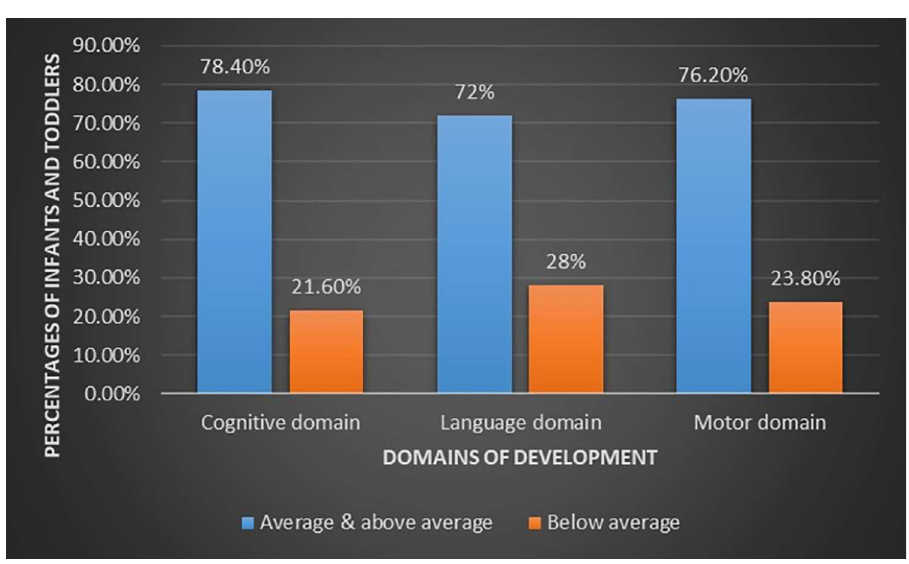
Fig 4. Classification of participants into two groups (Average & above average group and below average group) according to the cutoff point of composite score of Bayley Scales.